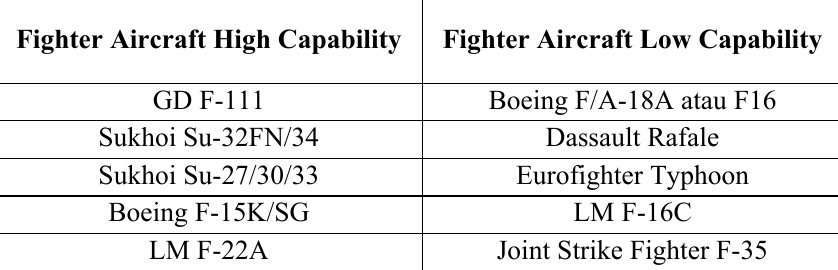
Table 2. Fighter Aircraft